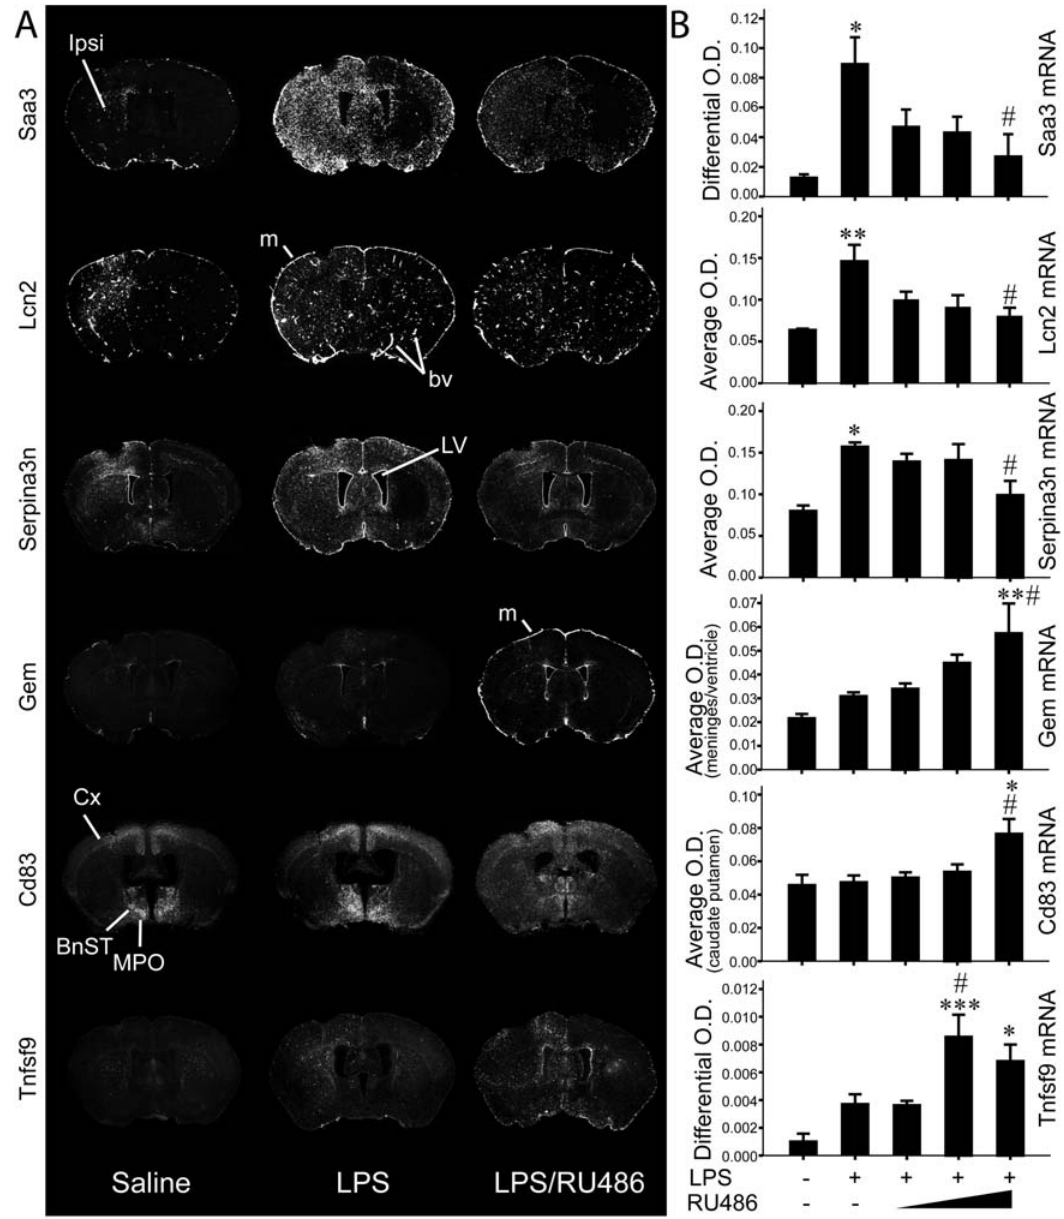
Figure 3. Bimodal RU486 effect on CNS inflammation as demonstrated by APRs and genes only responsive to LPS upon GR-antagonism. (A) Dark-field photomicrographs showing hybridization signals of the specified transcripts from mice that received saline or, LPS or, LPS/RU486 combined treatments. (B) Semi-quantitative analysis of mRNA levels [optical density (O.D.)] in mouse brains 12 h after the intracerebral infusions. Absence (-) or presence ( + ) of LPS or increasing doses of RU486 is indicated. Quantification methods may vary among transcripts; see ‘‘Experimental Procedures’’ section. Results represent means 6 SEM of 3–5 mice per group. One-way ANOVA followed by a Tukey’s HSD multiple comparison test: significantly different (* p , 0.05, ** p , 0.01, *** p , 0.005) from the saline-injected group; significantly different ( # p , 0.05) from the LPS-treated group. Abbreviations: BnST, bed nucleus of stria terminalis; bv, blood vessel; Cx, cortex; Ipsi, ipsilateral; LV, lateral ventricle; m, meninges; MPO, medial preoptic nucleus.